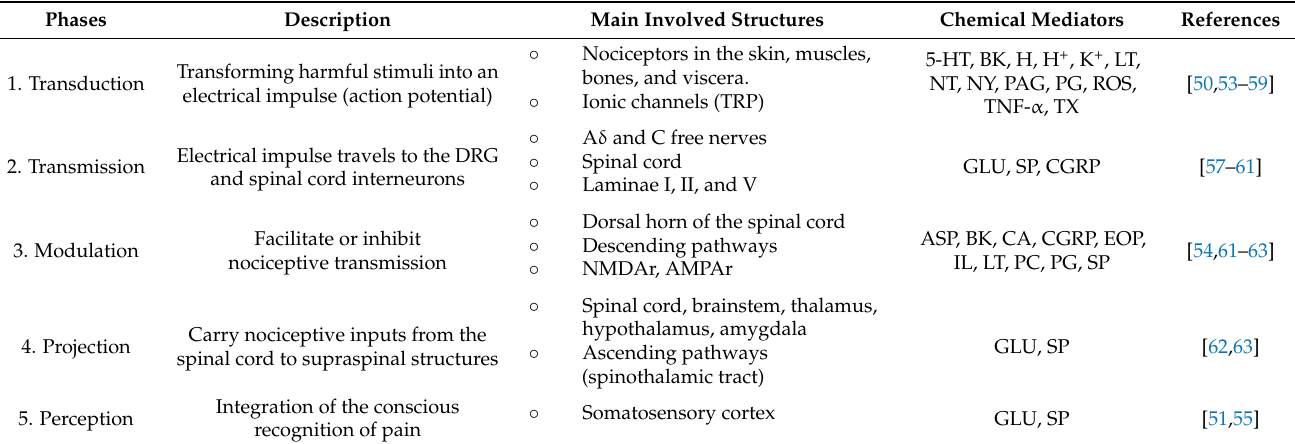
Table 1. Phases and characteristics of the nociceptive pathway caused by bite injuries in